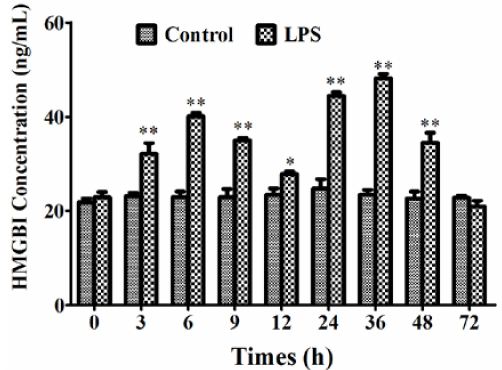
Figure 3. The effect of LPS on HMGB1 release in the piglet model. The piglets were inoculated with LPS for 3, 6, 9, 12, 24, 36, 48, and 72 h, blood samples were collected for the detection of HMGB1 release. * p < 0.05; ** p <